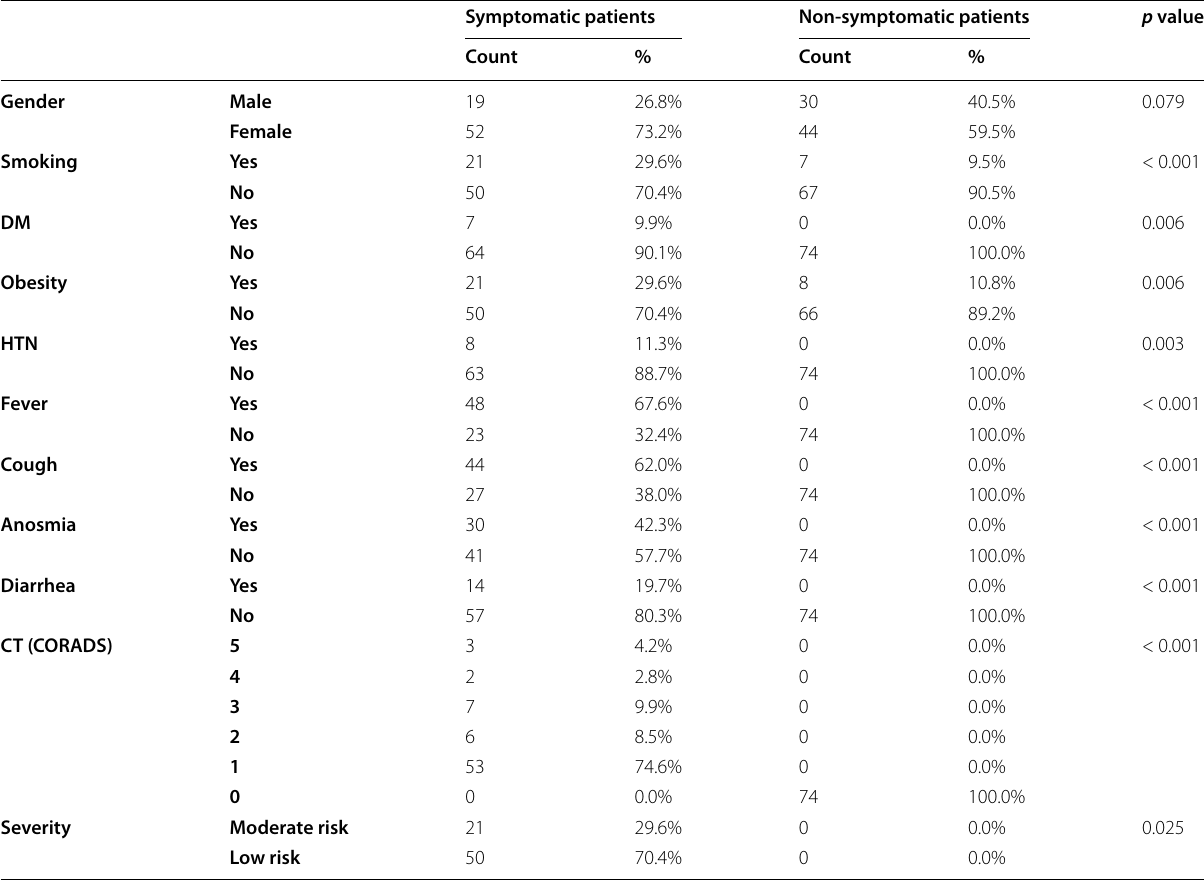
Table 2 Symptoms and comorbidities of the patients